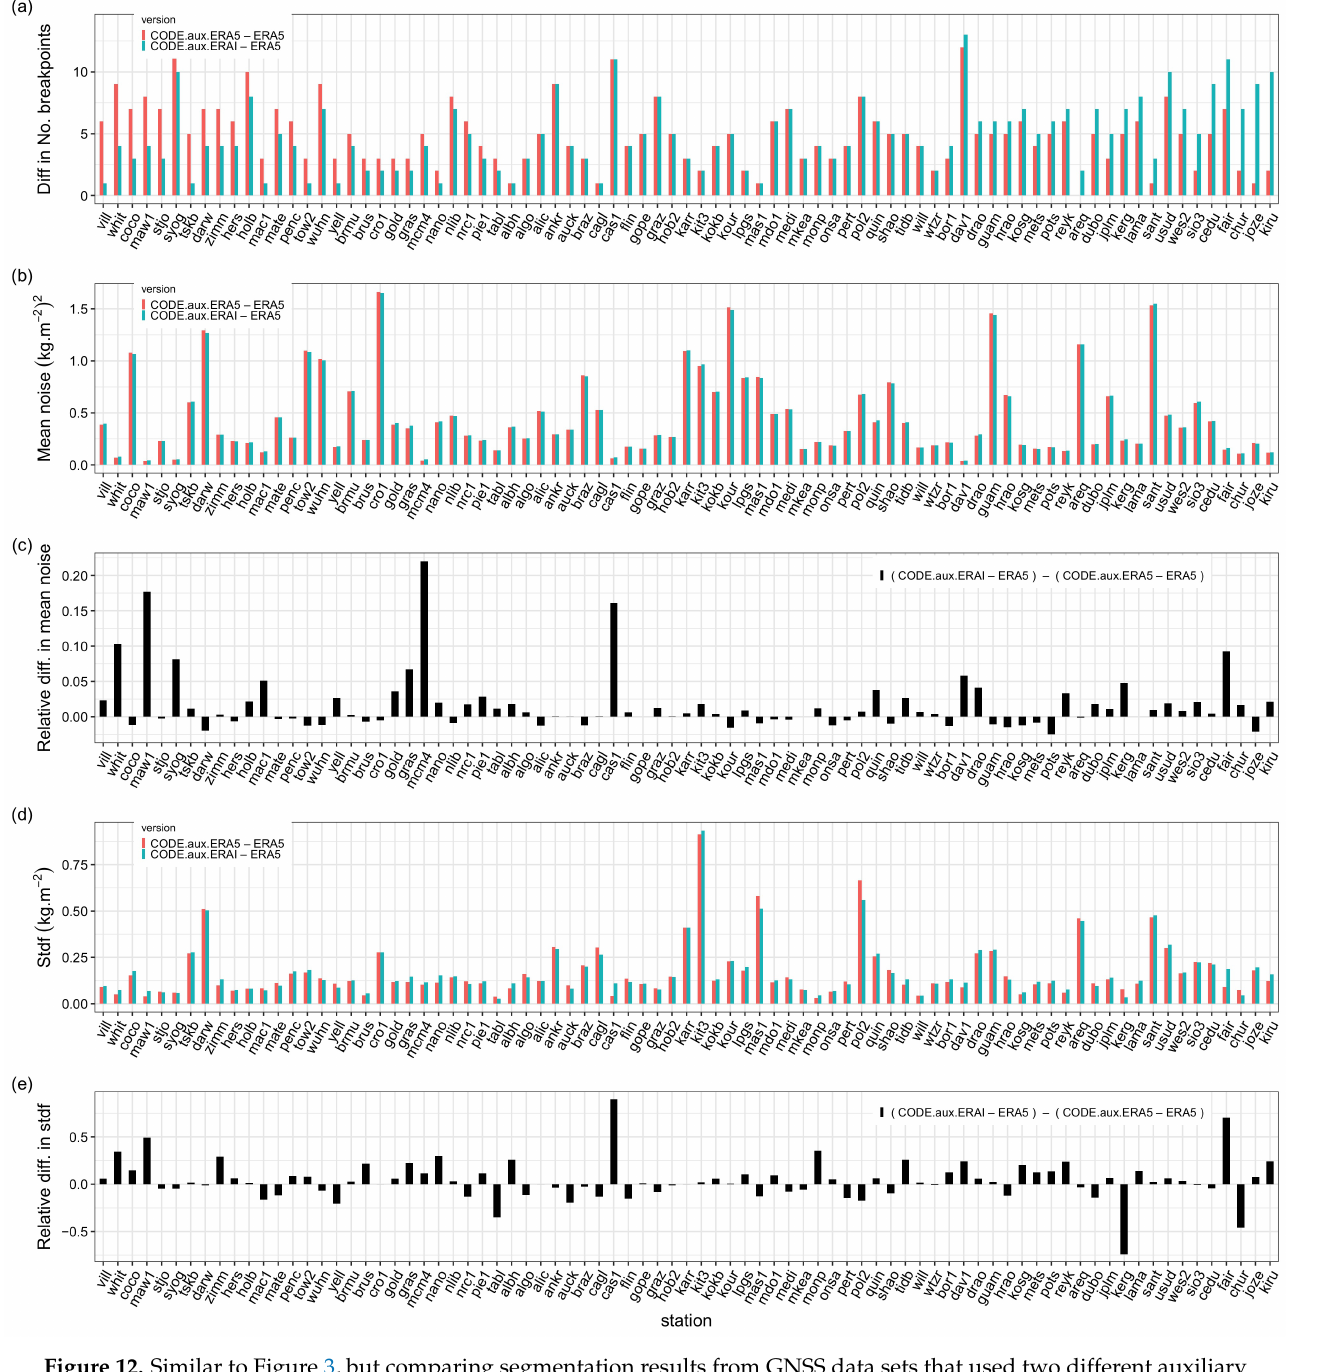
Figure 12. Similar to Figure 3, but comparing segmentation results from GNSS data sets that used two different auxiliary data, from ERA-Interim (ERAI) and